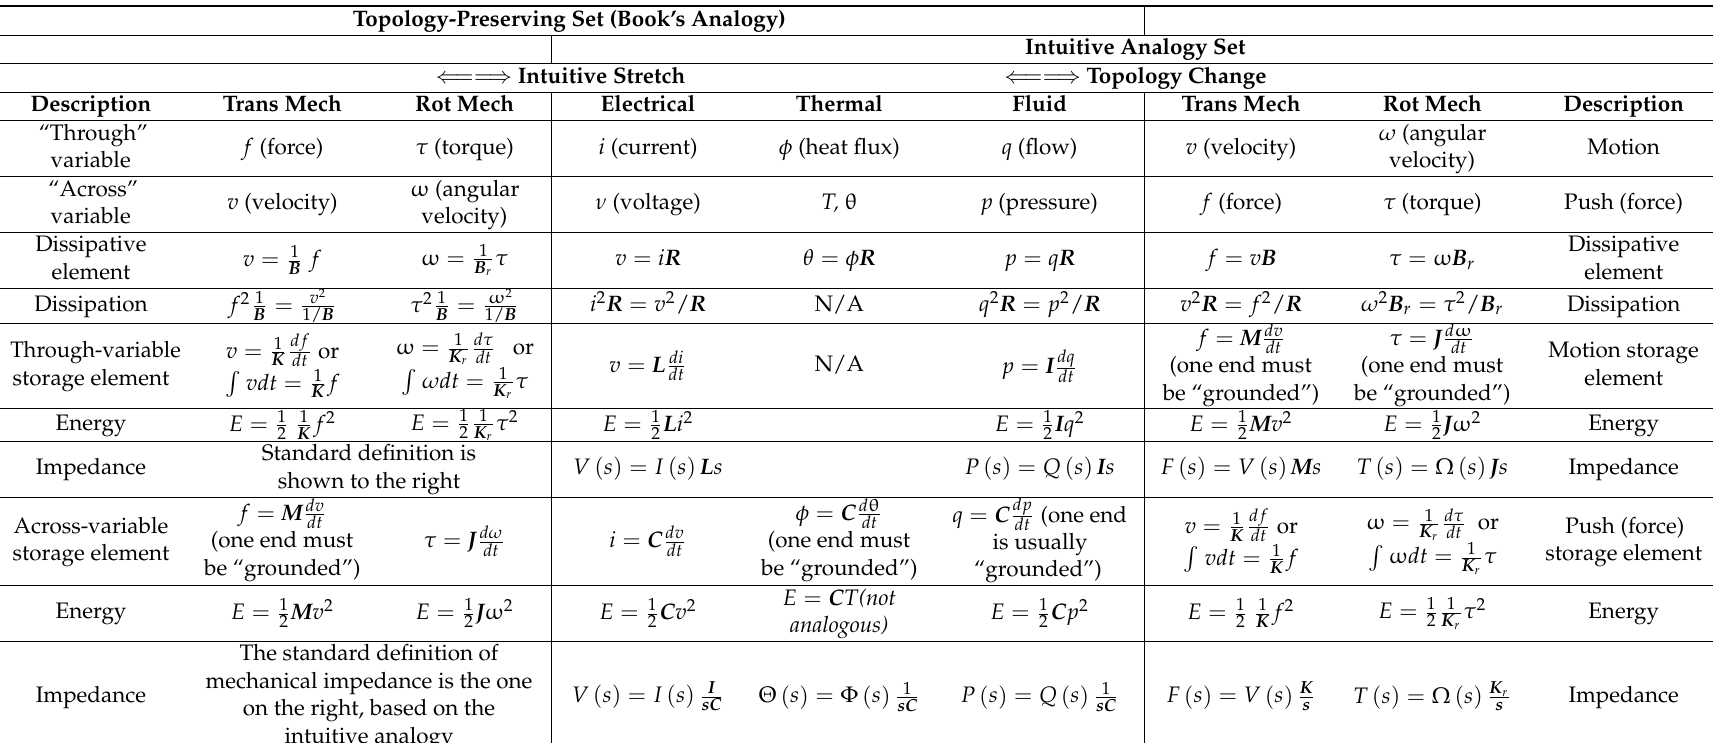
Table 1. System analogy used for developing the new